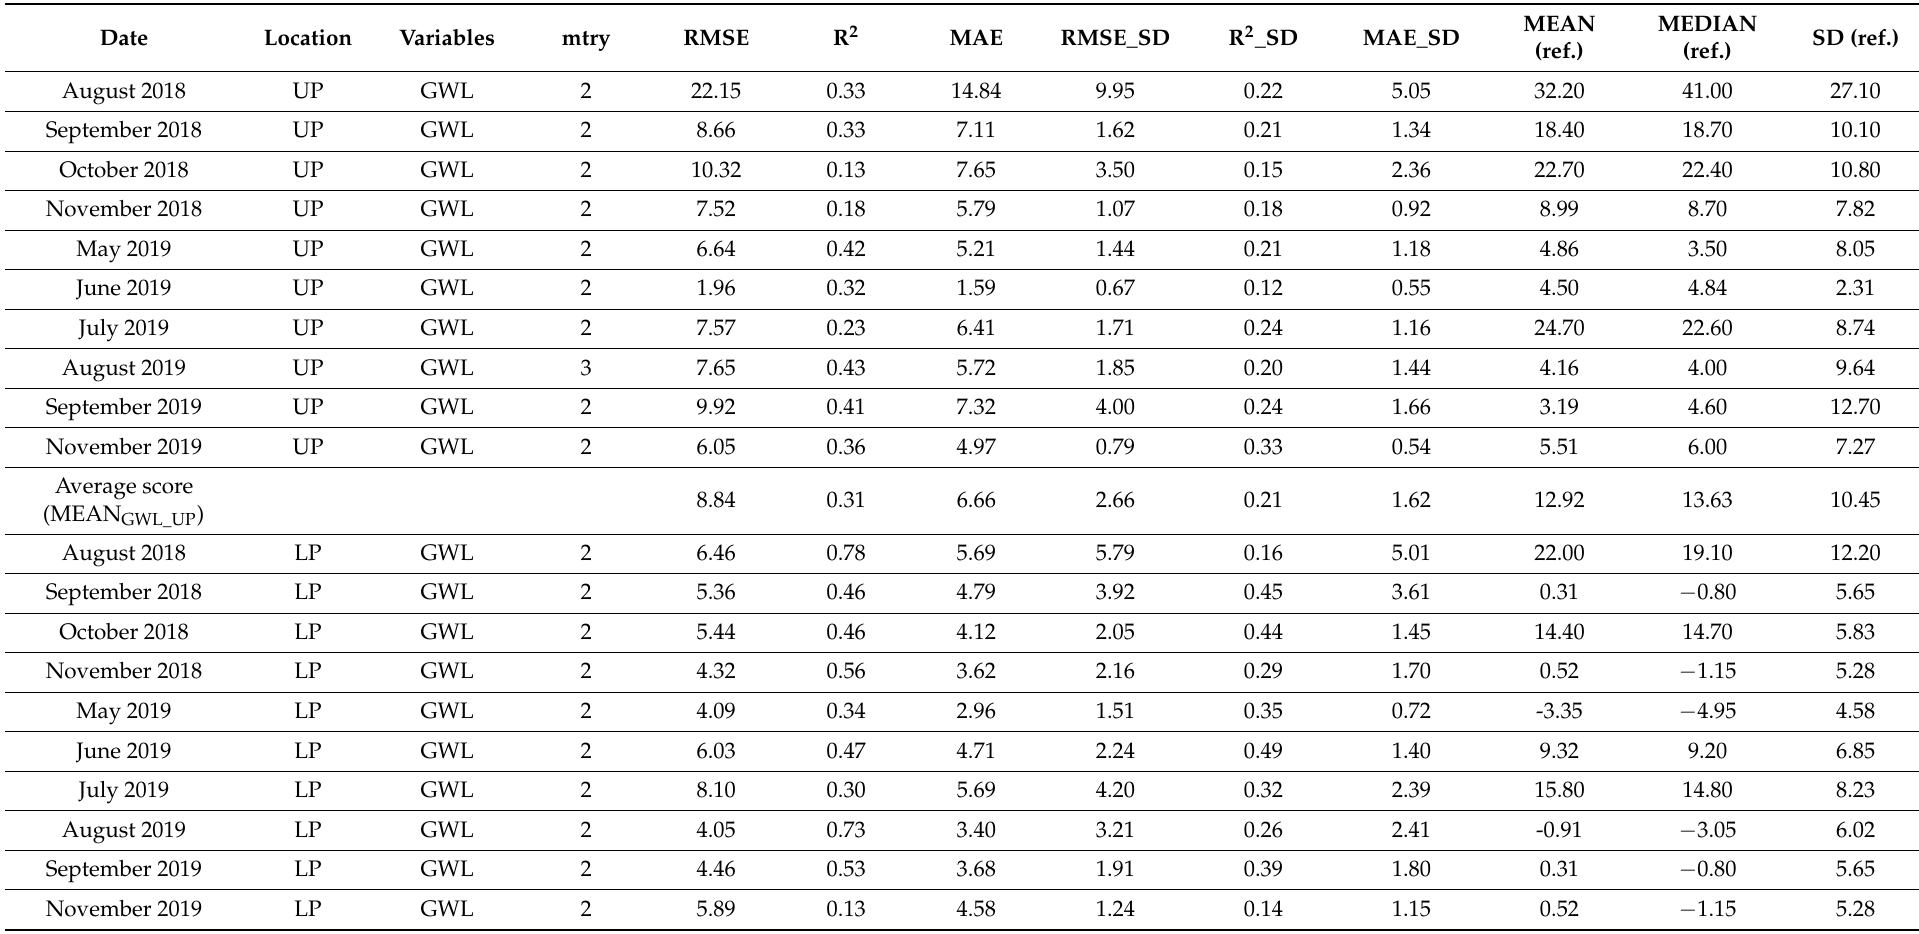
Table 2. Statistical performance of the CAST models using cross-validation and a spatially constrained 5-fold based on the FFS method. Mtry value is the number of variables available for splitting at each model tree node. Model performance was assessed through the Root-Mean-Square-Error (RMSE), the Coefficient of Determination (R 2 ), Mean Absolute Error (MAE), and their respective Standard Deviations (SD). Reference estimates were assessed through MEAN, MEDIAN, SD, and the average score (MEAN) for both GWL and SM models, and reference